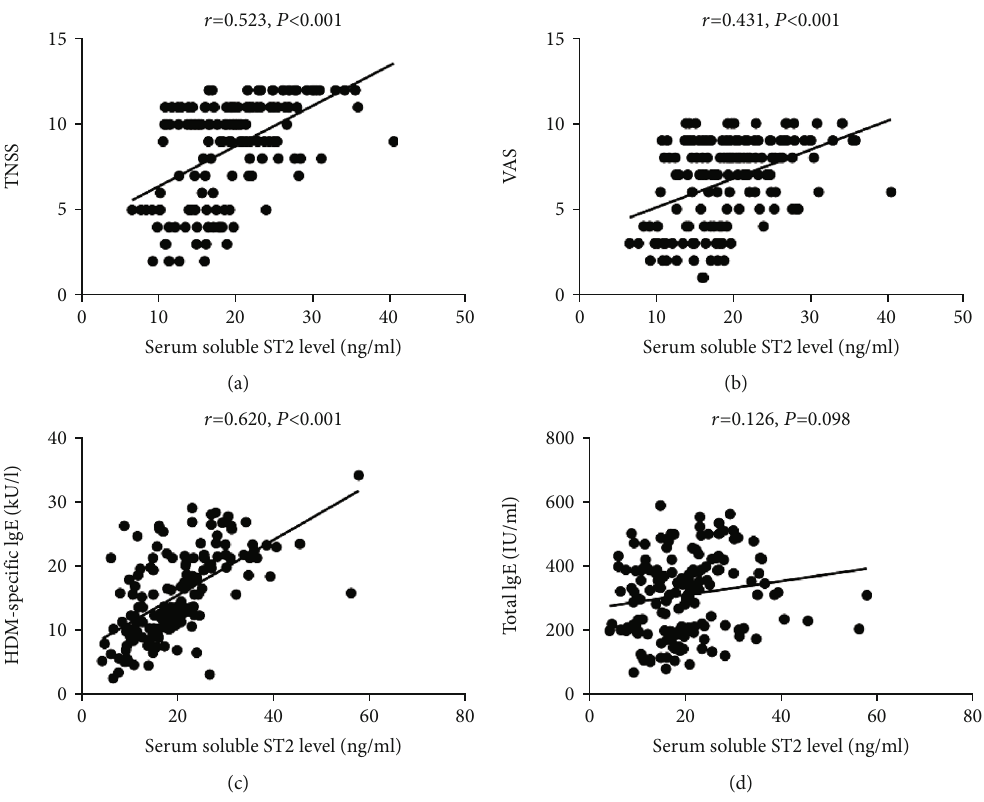
Figure 2: Correlation between serum sST2 levels and TNSS (a), VAS (b), HDM-speci fi c IgE (c), and total IgE (d). sST2: soluble suppressor of tumorigenicity 2; HDM: house dust mite; TNSS: total nasal symptom score; VAS: visual analogue scale. Table 2: The demographic and clinical variables between two